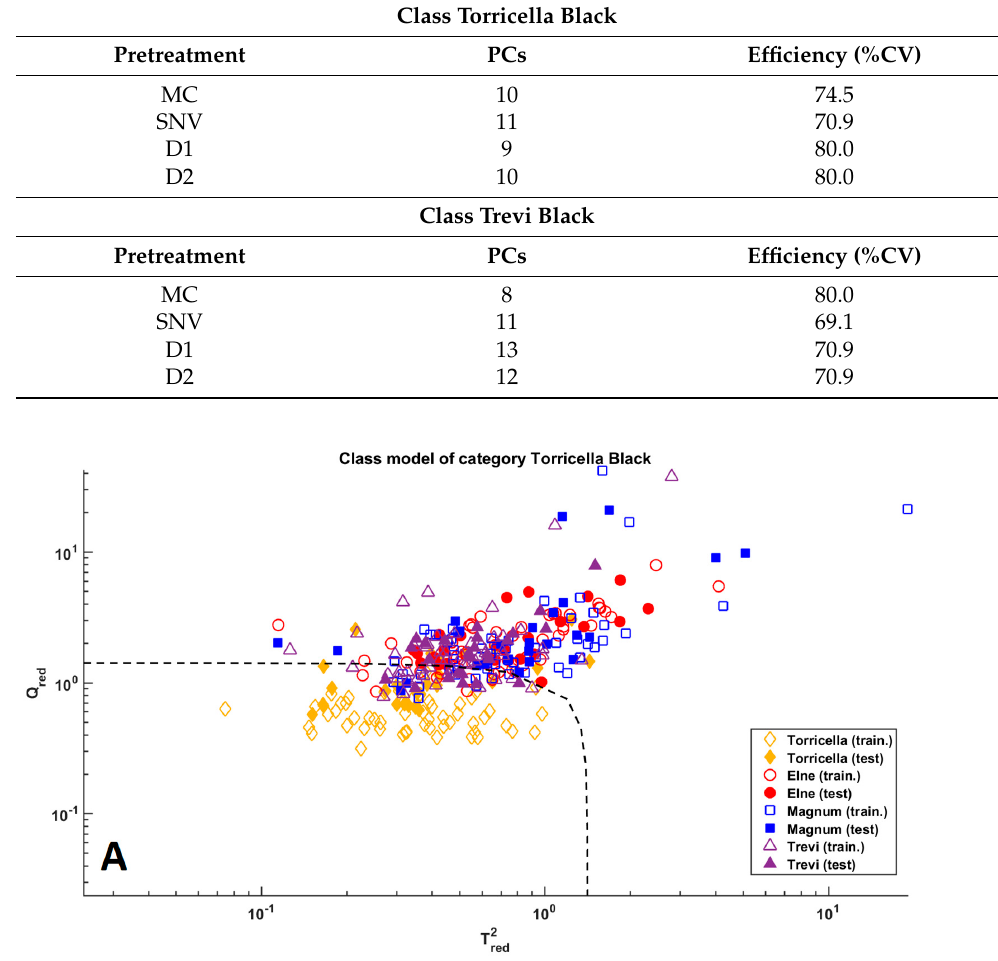
Table 1. SIMCA results associated with the modeling of class Torricella Black and class Trevi Black.